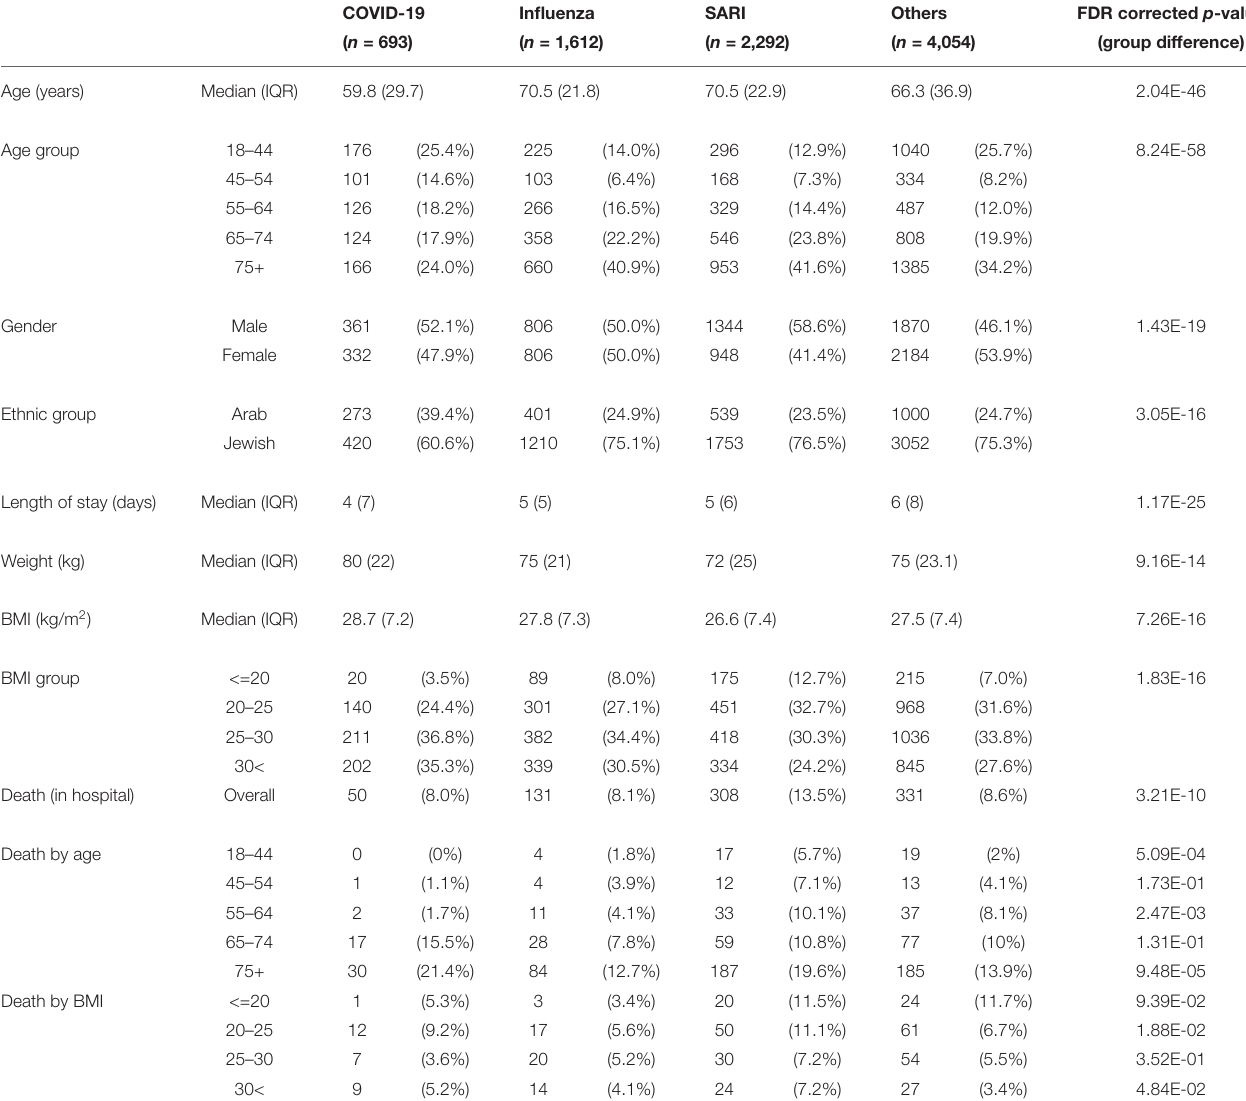
TABLE 1 | Patient characteristics, length of stay, and mortality.